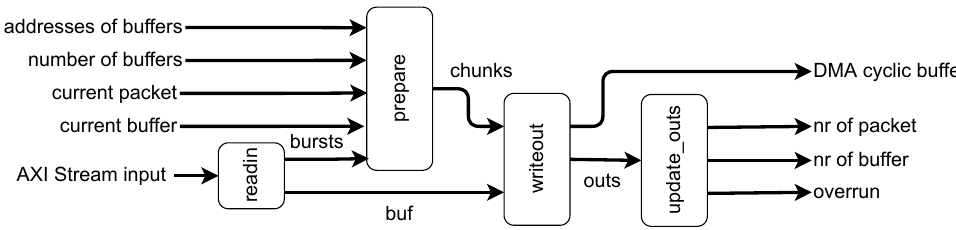
Figure 7. Structure of the HLS-implemented core of the DMA